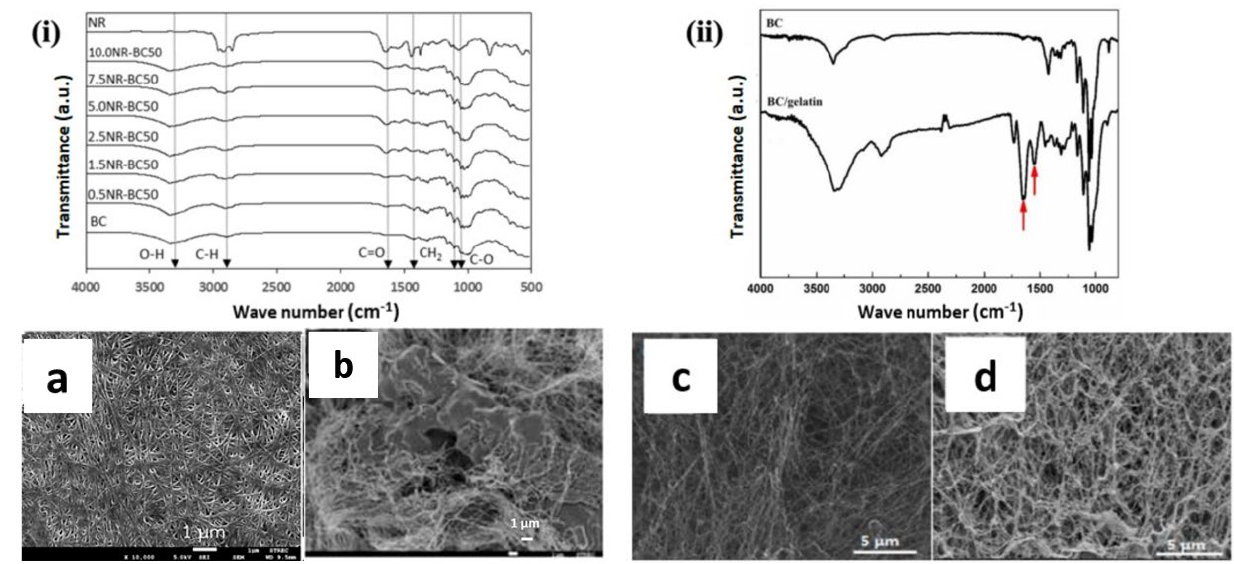
Figure 4. FTIR spectra and SEM micrographs; ( i ) FTIR of BC blended with natural rubber (NR) with varying NR composition, and FESEM micrograph for comparison ( a ) neat dried BC and ( b ) dried BC/NR blend, adapted from Potivara & Phisalapong [81]; and ( ii ) FTIR of BC/gelatin blend with neat BC and BC/gelatin blend (red arrows indicating signals from amide groups), with FESEM images comparison of ( c ) neat BC and ( d ) BC/gelatin blend, adapted from [82].